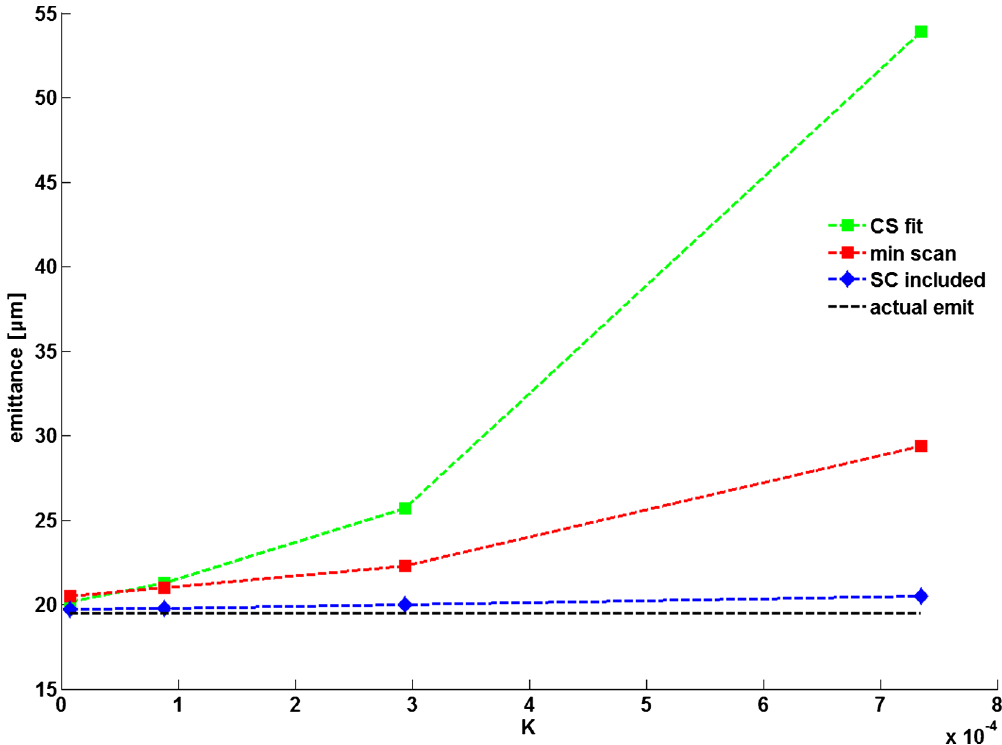
FIG. 6. Comparison of the emittance measured using different methods as a function of beam perveance ( K ): dashed green curve: CS parameter fitting method; red curve: cross-correlation determination at minimum of quad beam size scan; blue curve: two value method including space charge, showing small deviation from the actual